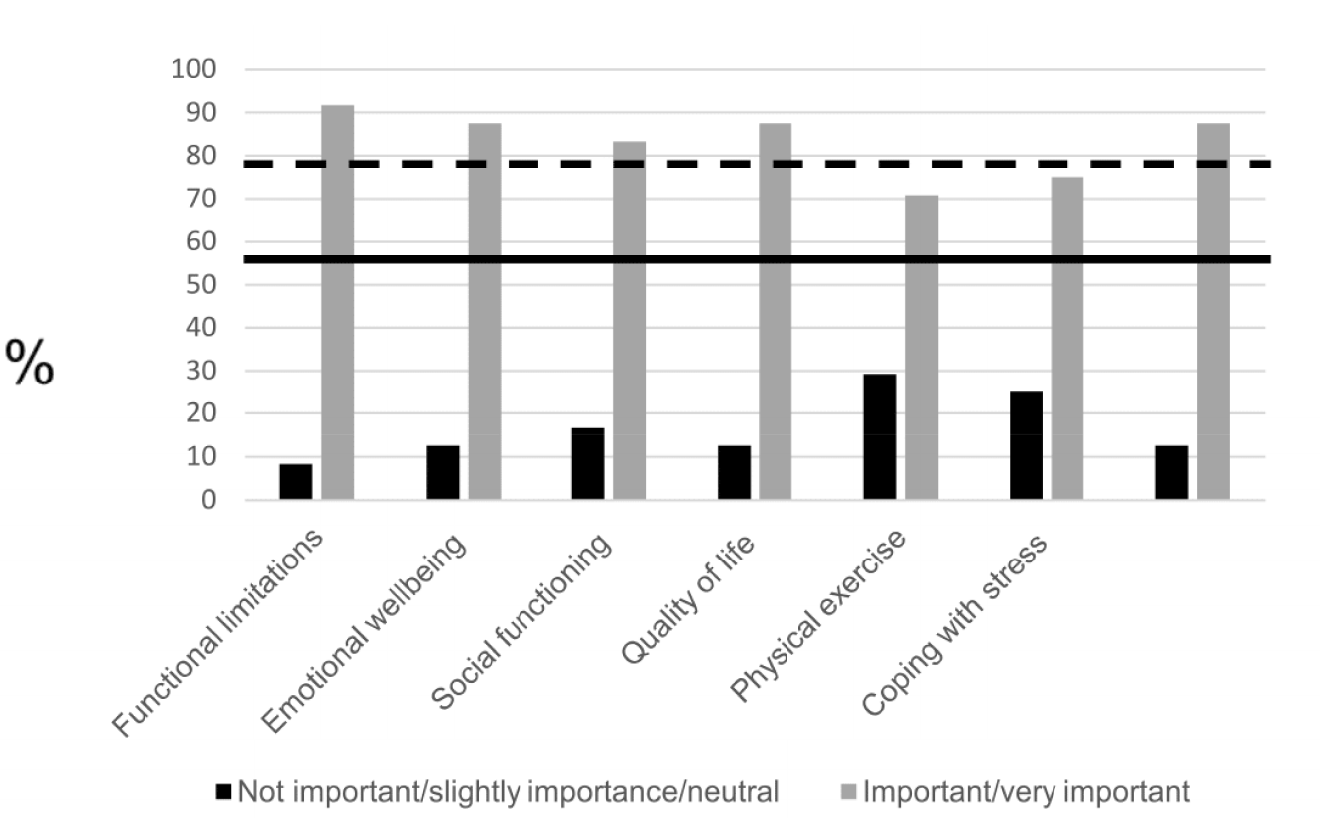
Fig 3. Round 3: Overview of the remaining health domains. Frequency distribution (%) of the importance to discuss each domain with healthcare professionals. The bold black line represents the 50% threshold. The bold black dotted line represents the 75% threshold.